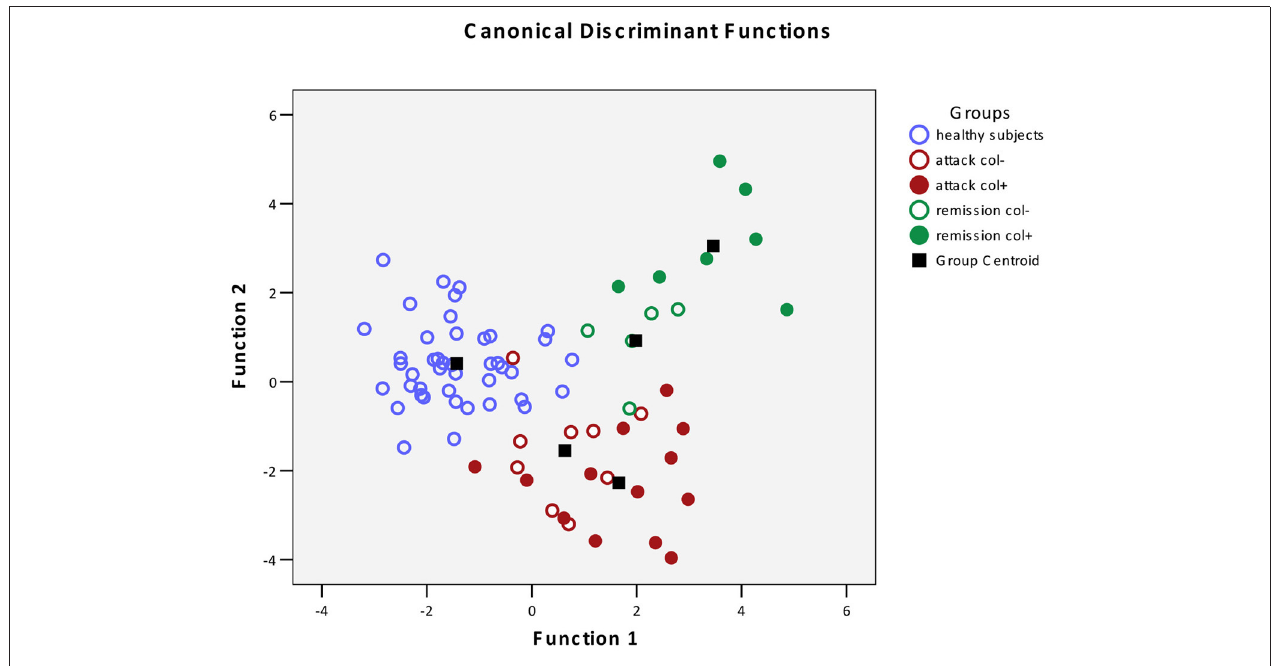
FIGURE 1 | Scatterplot of DA model based on systemic concentration of microbial components of the metabolome. Number of variables in the model—30 and grouping consists of five groups. Root 1, 2—discriminant functions 1 and 2 (1st and 2nd canonical roots). , Healthy subjects; , FMF